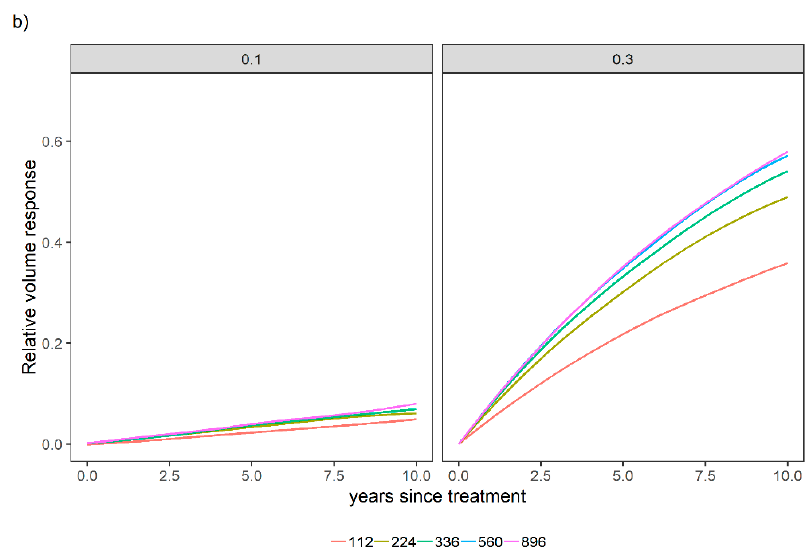
Figure 9. Relative stand-level volume response for two relative spacing scenarios [0.1 and 0.3] across different levels of N (112, 224, 336, 560, and 896 kg ha − 1 ) over time (years since treatment was established) when P was not applied ( a ) or when 28 kg ha − 1 of P was applied ( b ). Site index was held constant (S = 20 m).